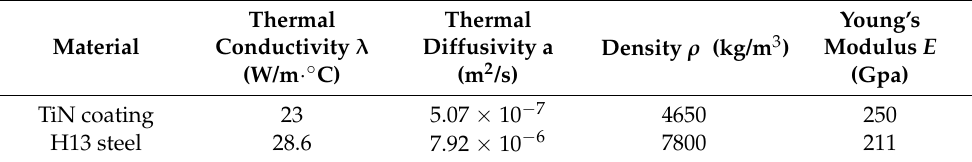
Table 1. Physical properties of TiN coating and H13